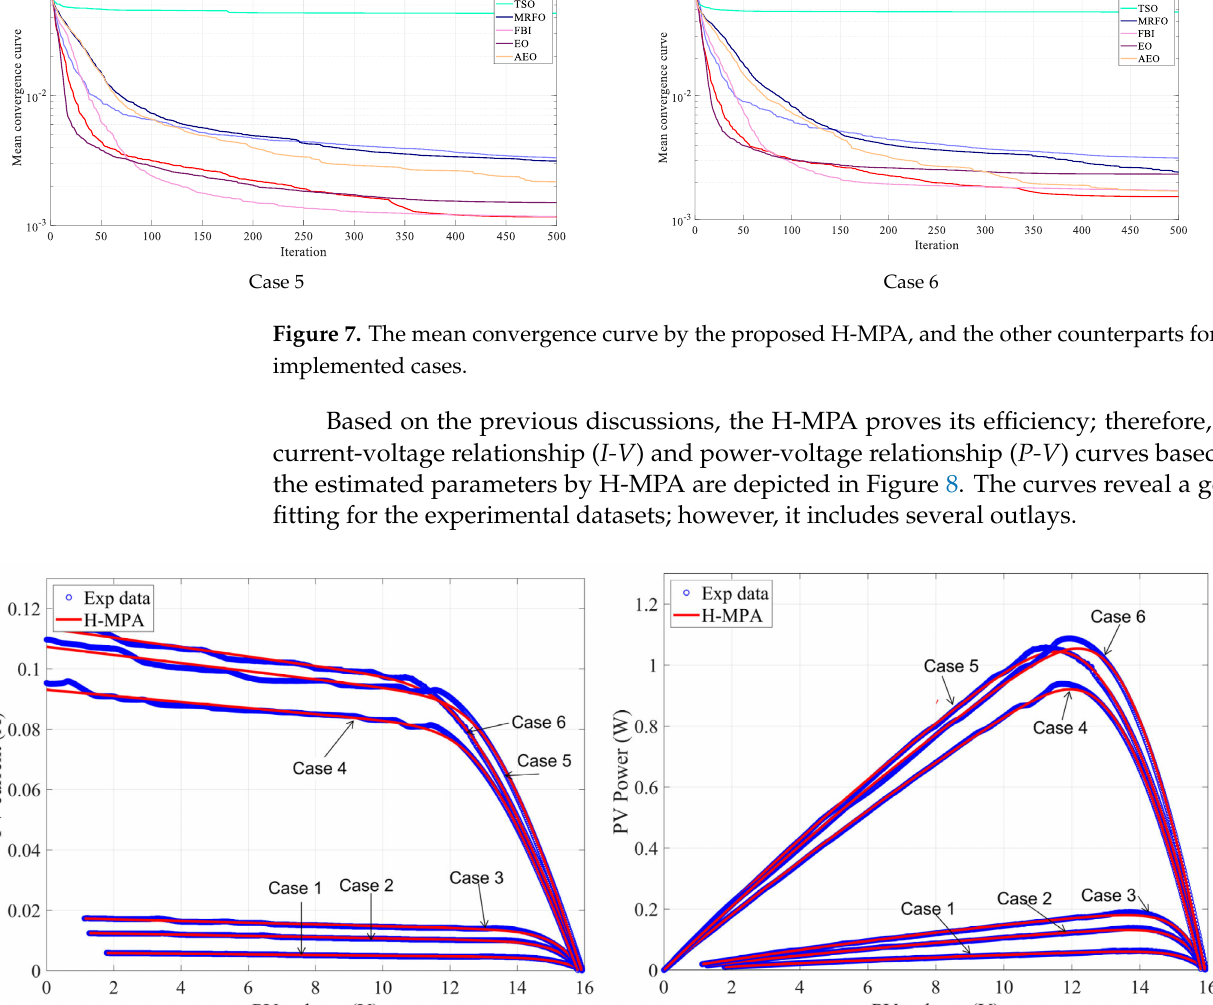
Figure 8. The characteristics of the DSSCs module under different environmental conditions ( a ) I-V relationships, and ( b ) P-V relationships.